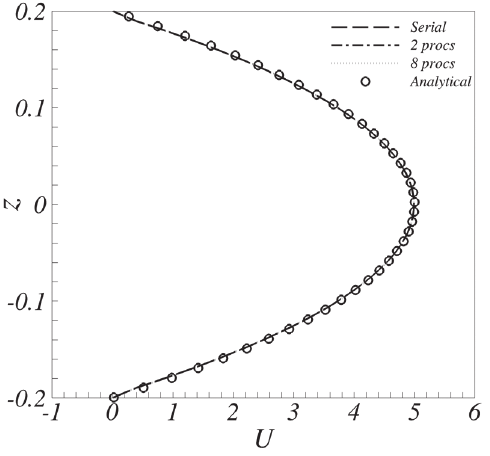
Figure 13 - Quantitative comparison of the velocity profile for a circular Poiseuille flow, obtained with the Immersed Boundary Method against an analytical